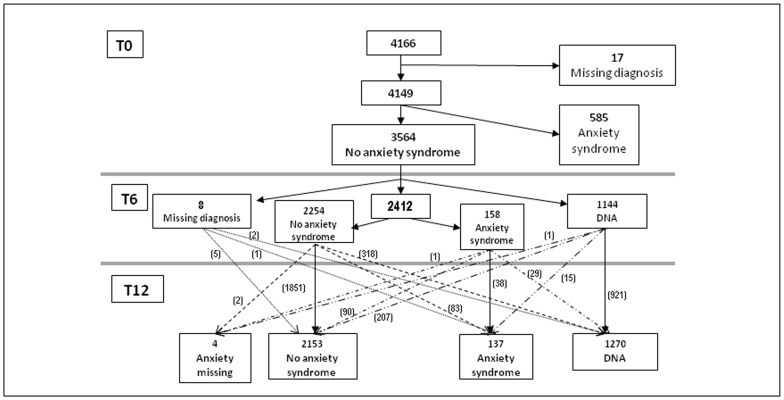
Flow chart of patients through the predictA-Spain study and numbers becoming anxious.Footnote to Figure 1: DNA: did not attend; T0, T6 and T12: baseline, 6 and 12 months interview. Anxiety syndromes measured by the Primary Care Evaluation of Mental Disorders, Patient Health Questionnaire (PRIME-MD-PHQ). 12,13